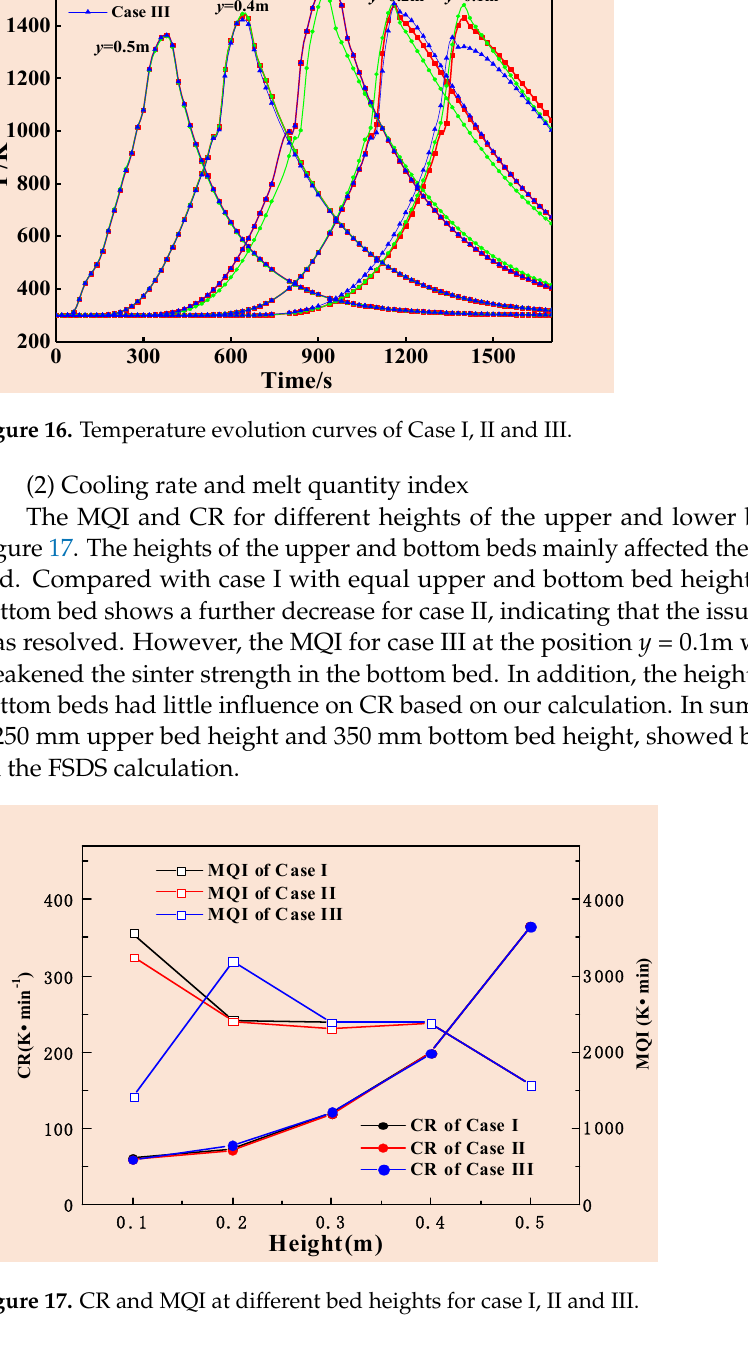
Figure 17. CR and MQI at different bed heights for case I, II and III. The parameters such as the maximum temperature ( T max ), residence time of melt zone, MQI and CR at a bed height of 0.4 m (upper bed) and 0.1 m (lower bed) for the FSDS technology with different heights of upper and lower bed layers are presented in Table 6. Table 6. Some parameters obtained from the temperature curves for cases I, II, and III.